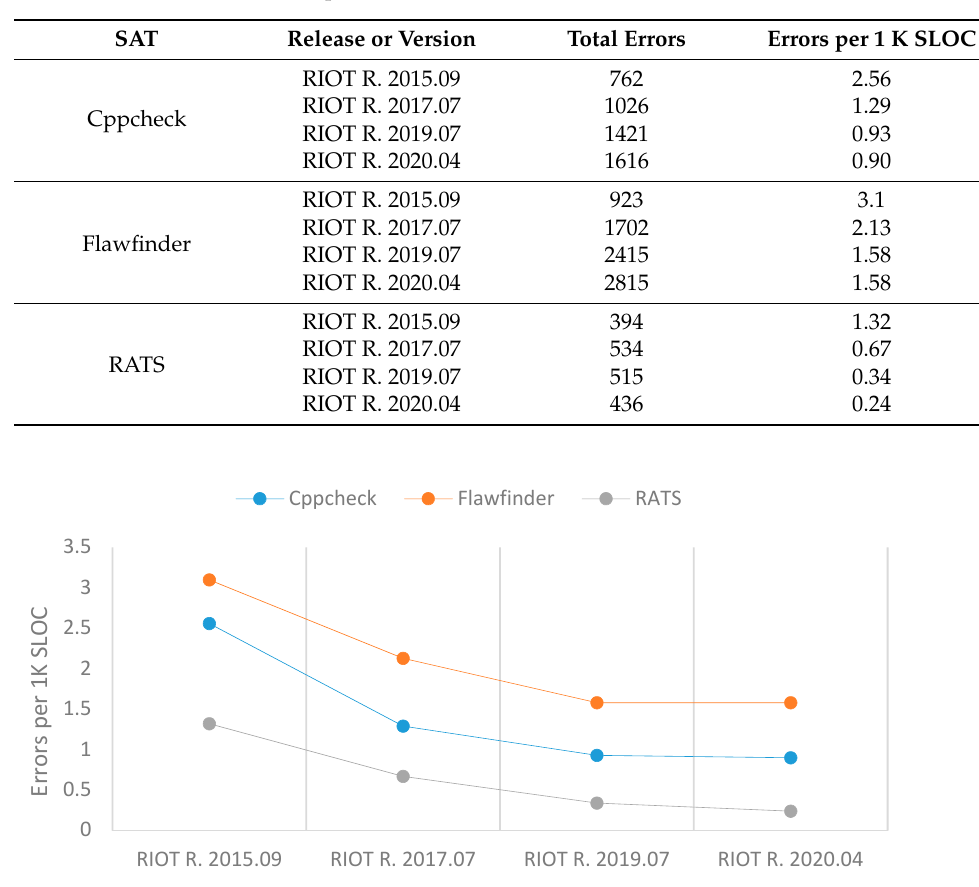
Table 4. Total errors and errors per 1K SLOC of RIOT.